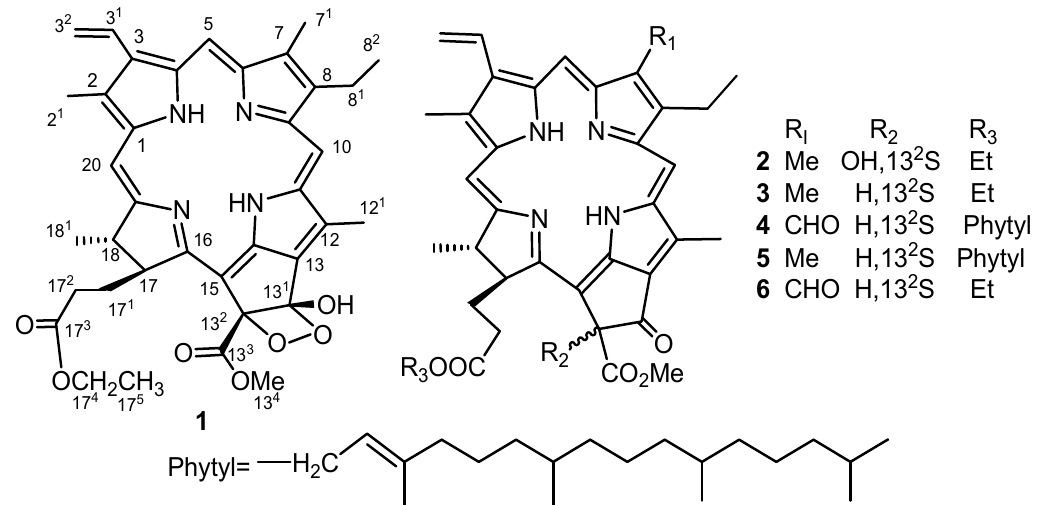
Figure 1. Phaeophytins from L. knorringiana aerial